Question: Describe this figure in one sentence.
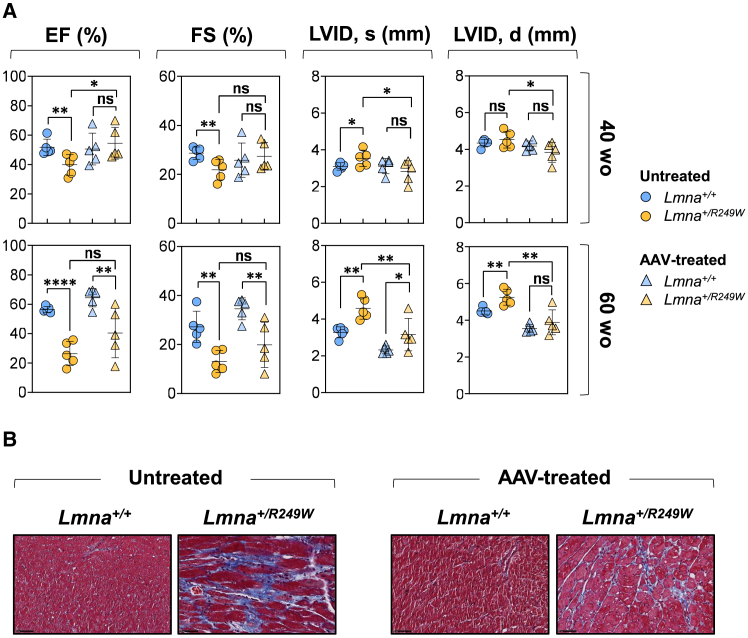
Answer: Single dose of AAV9-Cas9/sg745T treatment improves cardiac function in Lmna +/R249W mice (A) Echocardiographic measurements of LVID, s; LVID, d; EF; and FS at 40 and 60 weeks of age. The echocardiographic study was conducted in untreated ( n = 5 of each genotype) and AAV-treated ( n = 5 of each genotype) males. Data are represented as mean ± SD. ns, non-significant differences; ∗ p < 0.05; ∗∗ p < 0.01; ∗∗∗∗ p < 0.0001. (B) Representative images with Masson’s trichrome staining of heart sections from untreated ( n = 3 of each genotype) and AAV-treated ( n = 3 of each genotype) males at 50 weeks of age. Scale bars, 50 μm.